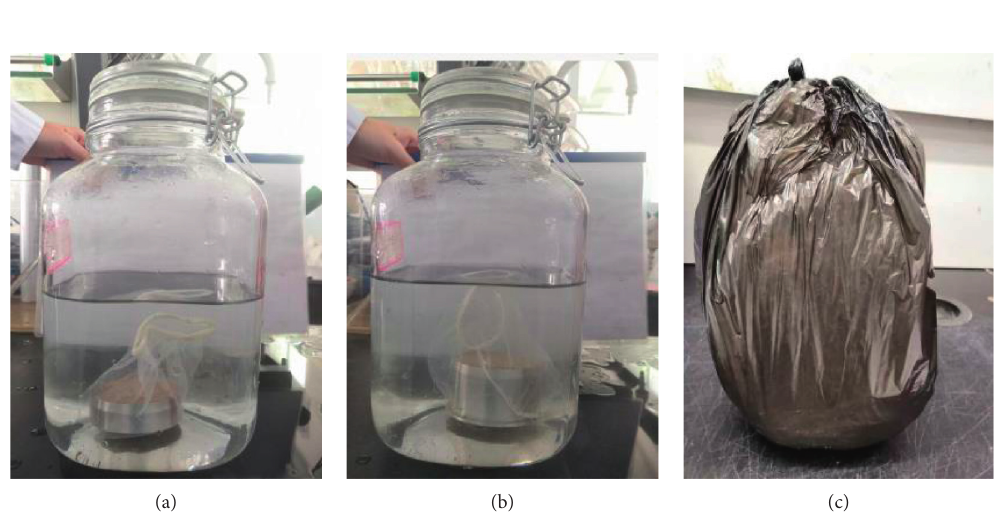
Figure 3: The picture of preparation of indoor soaking contaminated samples by TCE. (a) 2cm ring knife soaked sample. (b) 4cm ring knife soaked sample. (c) Sealed and stored away from